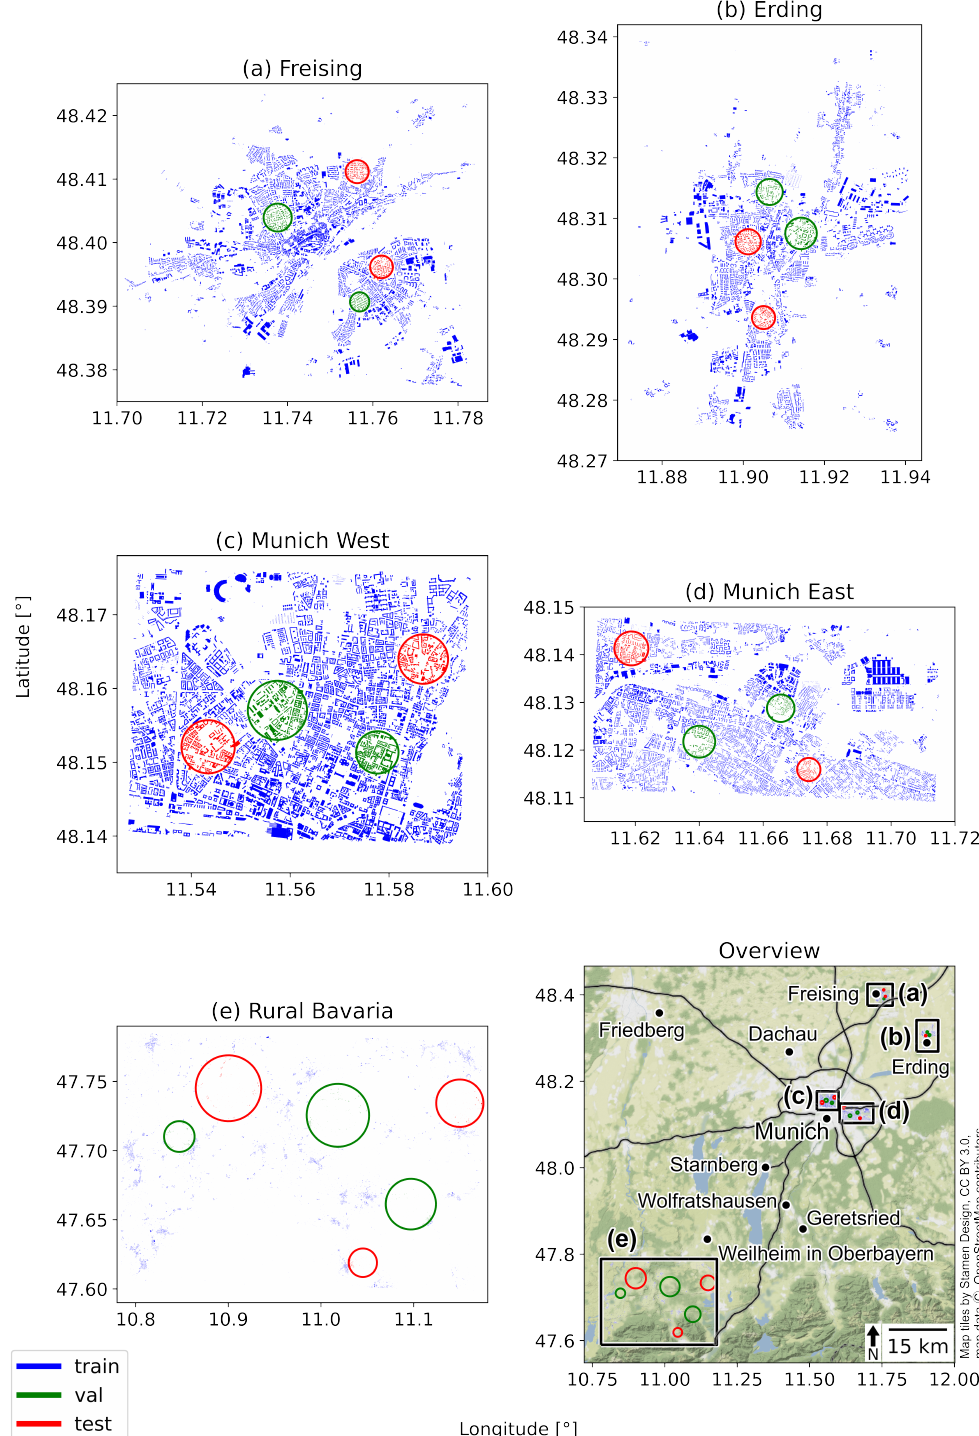
Figure 4. Data split of the large-scale dataset large-auto with areas containing training (train), valida- tion (val), and test data. One detailed map for each region ( a – e ) and one overview map that illustrates their spatial relation: ( a ) Freising in the very north; ( b ) Erding in the very east; ( c , d ) two areas in Munich centrally; ( e ) sparsely populated rural area in the